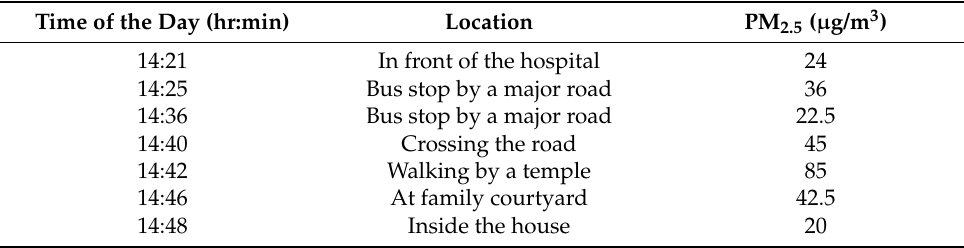
Table 2. An example of a longer walk from the hospital to home on 10 April 2019.